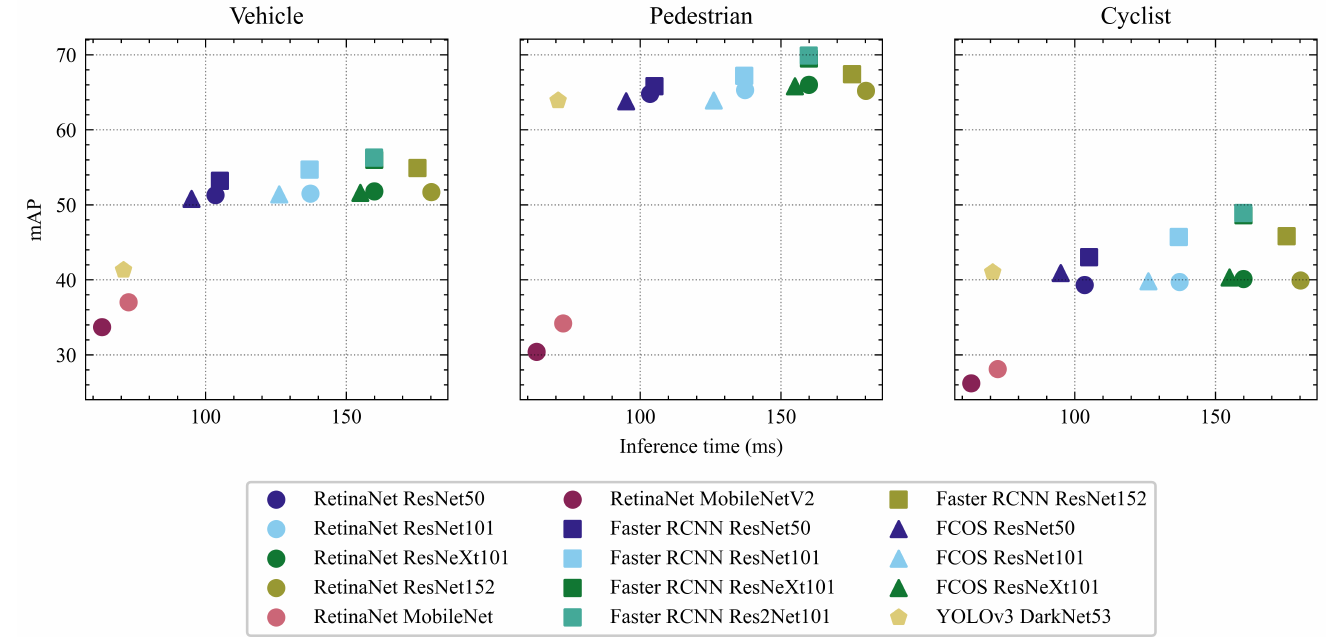
Figure 5. Inference time versus accuracy of high-resolution models for each object class with difficulty level